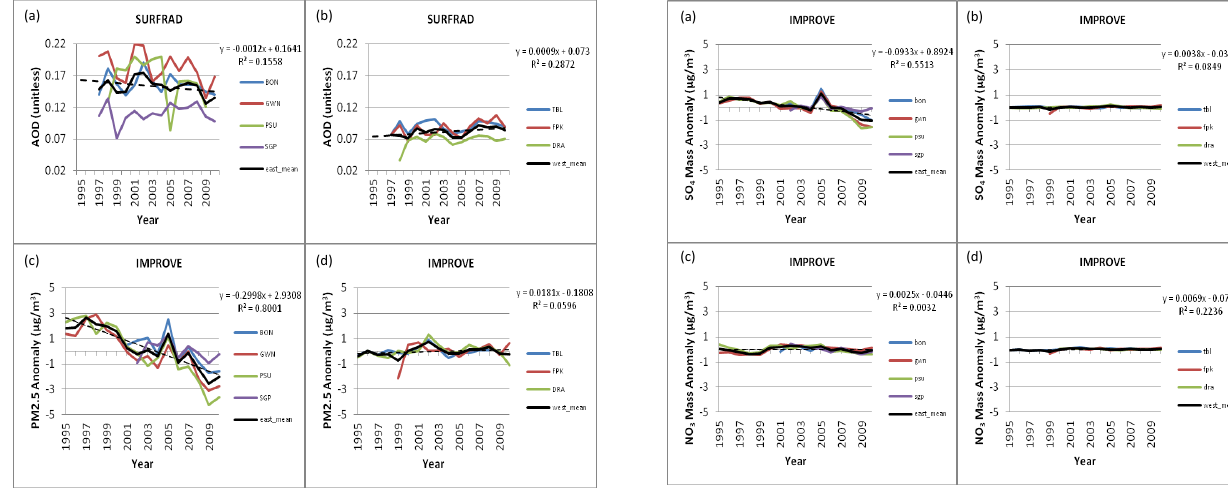
Figure 5: Annual anomalies of AOD from SURFRAD (first row) and PM 2.5 from IMPROVE 3 Fig. 5. Annual anomalies of AOD from SURFRAD (first row) and (second row) for each site (colored line) and the network mean (solid black line) together with 4 PM 2 . 5 from IMPROVE (second row) for each site (colored line) and the LSF (dash black line) to the network mean. The best-fit equation and coefficient of 5 the network mean (solid black line) together with the LSF (dash determination (R 2 ) are given at right in each panel. The left column represent eastern US 6 black line) to the network mean. The best-fit equation and coeffi- while the right column represent western US 7 cient of determination ( R 2 ) are given at right in each panel. The left column represent eastern US while the right column represent western US.